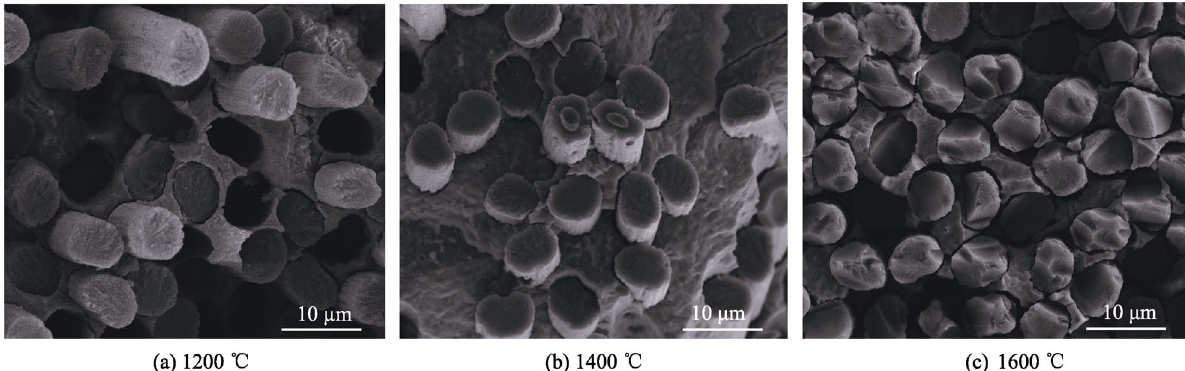
Fig. 6 Fracture surfaces of the C/mullite composites without interfacial coating after annealing at (a) 1200, (b) 1400, and (c) 1600 ℃